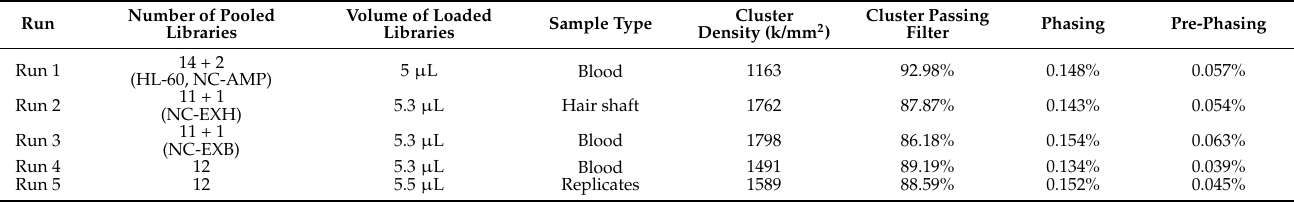
Table 1. Loaded libraries and sequence quality metrics of five sequencing